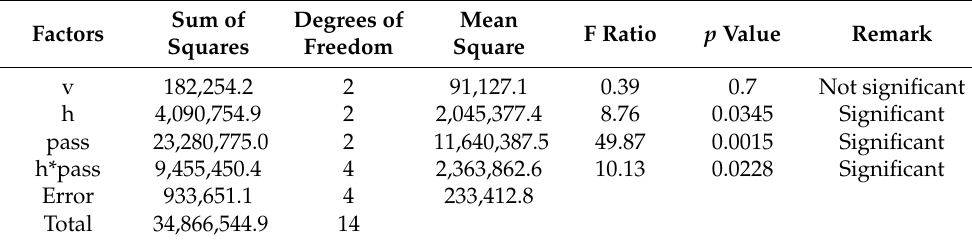
Table 9. ANOVA table for density of